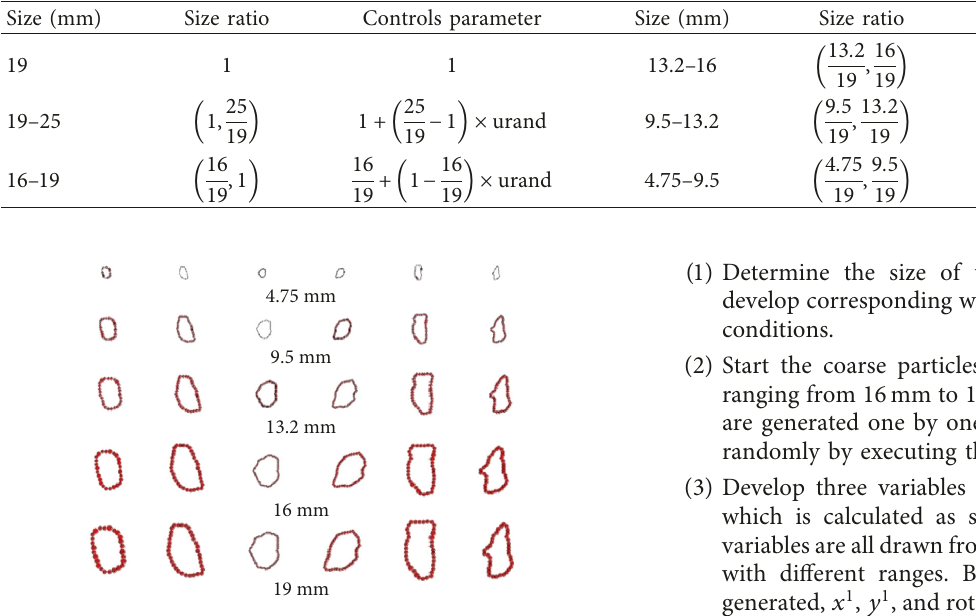
Figure 4: Virtual size reconstitutions based on standard particles.